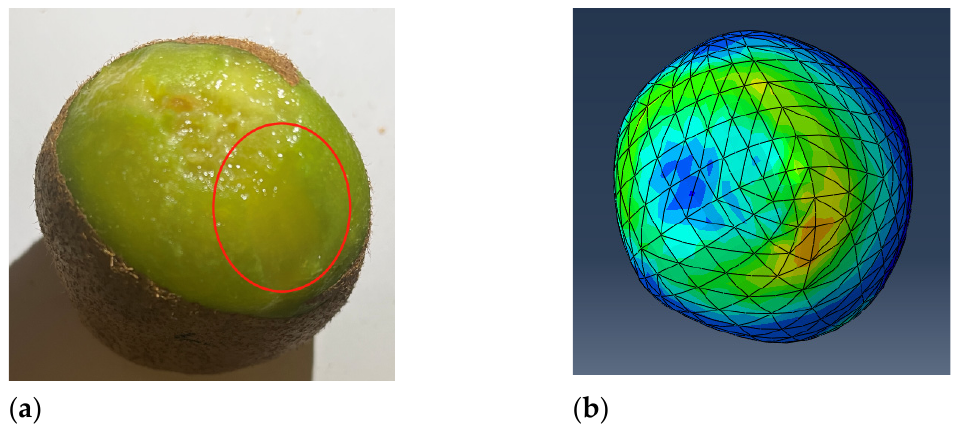
As can be seen from Figure 9, the top edge of the kiwifruit was hit the most severely when moving from the pipe to the fruit basket, reaching 0.053 MPa. It was equivalent to the force in the compression test of 50 N, and the damage formed was more obvious. In the corresponding verification test, the top of the kiwifruit was also damaged during the entry and receiving process. After removing the peel of the kiwifruit, bruises were found on the tip of the kiwifruit. Figure 10 shows the comparison chart between the simulation and test, and it can be seen that the injured part was consistent.